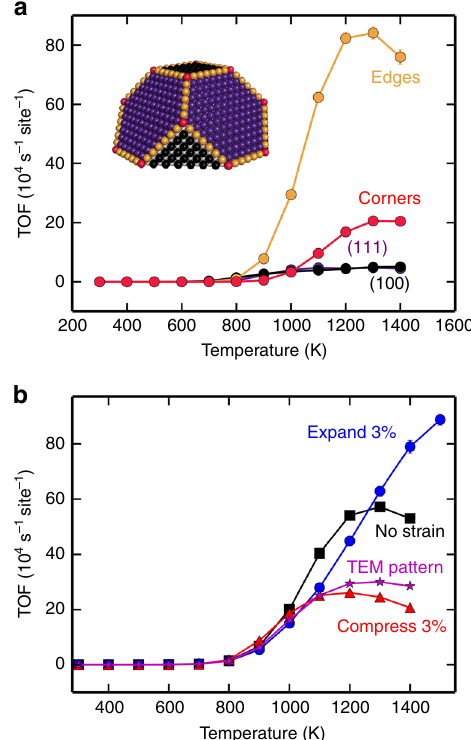
Fig. 3 Light-off behaviour of CO oxidation determined by kinetic Monte Carlo simulations. a Light-off simulations showing site contributions to the total turnover frequency (TOF) for an unstrained NP. b Light-off simulations for various strain patterns. The simulated TOF is shown versus temperature. The data point markers are in most cases larger than the error bars. The error bars correspond to one standard deviation between 16 identically prepared simulations. Partial pressures: p(CO) = 20 mbar